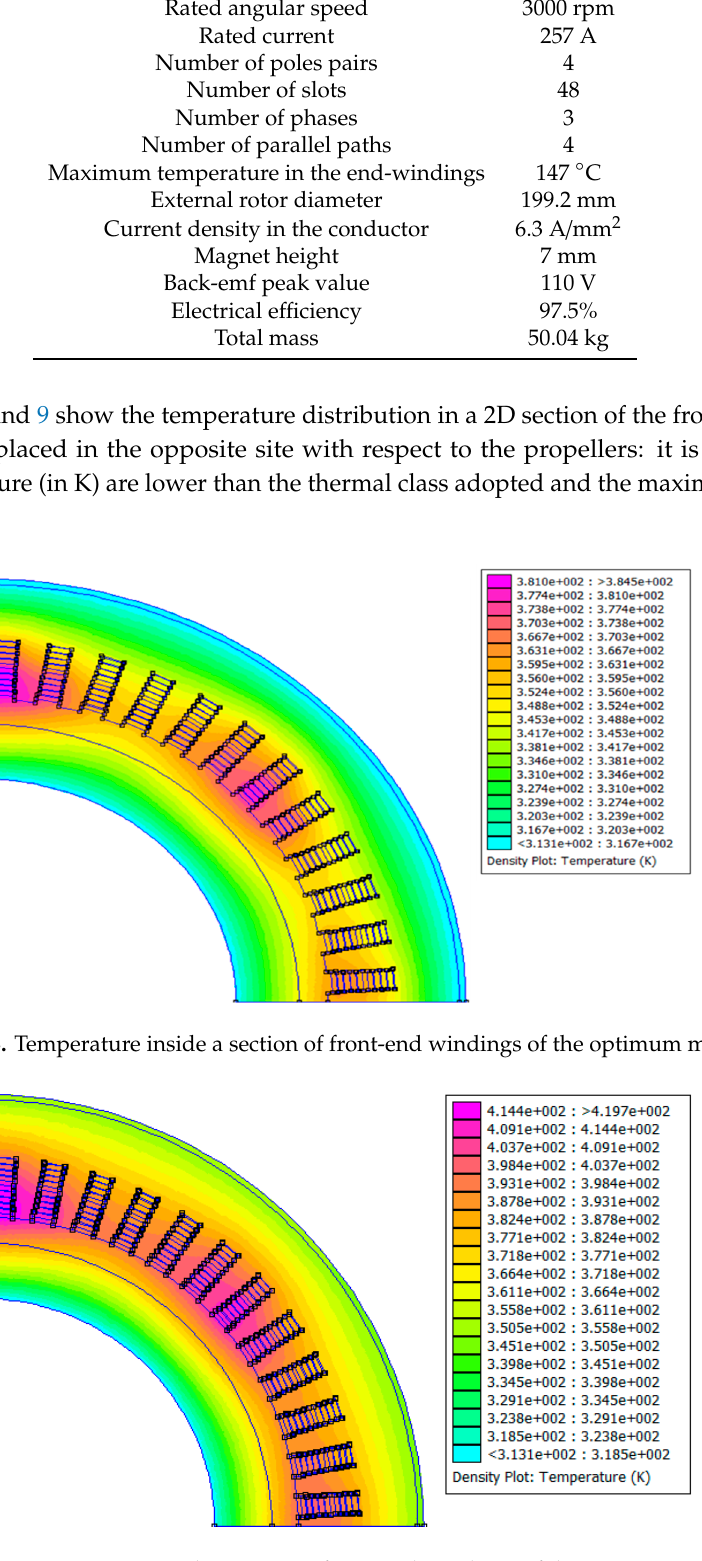
Figure 9. Temperature inside a section of rear-end windings of the optimum motor.